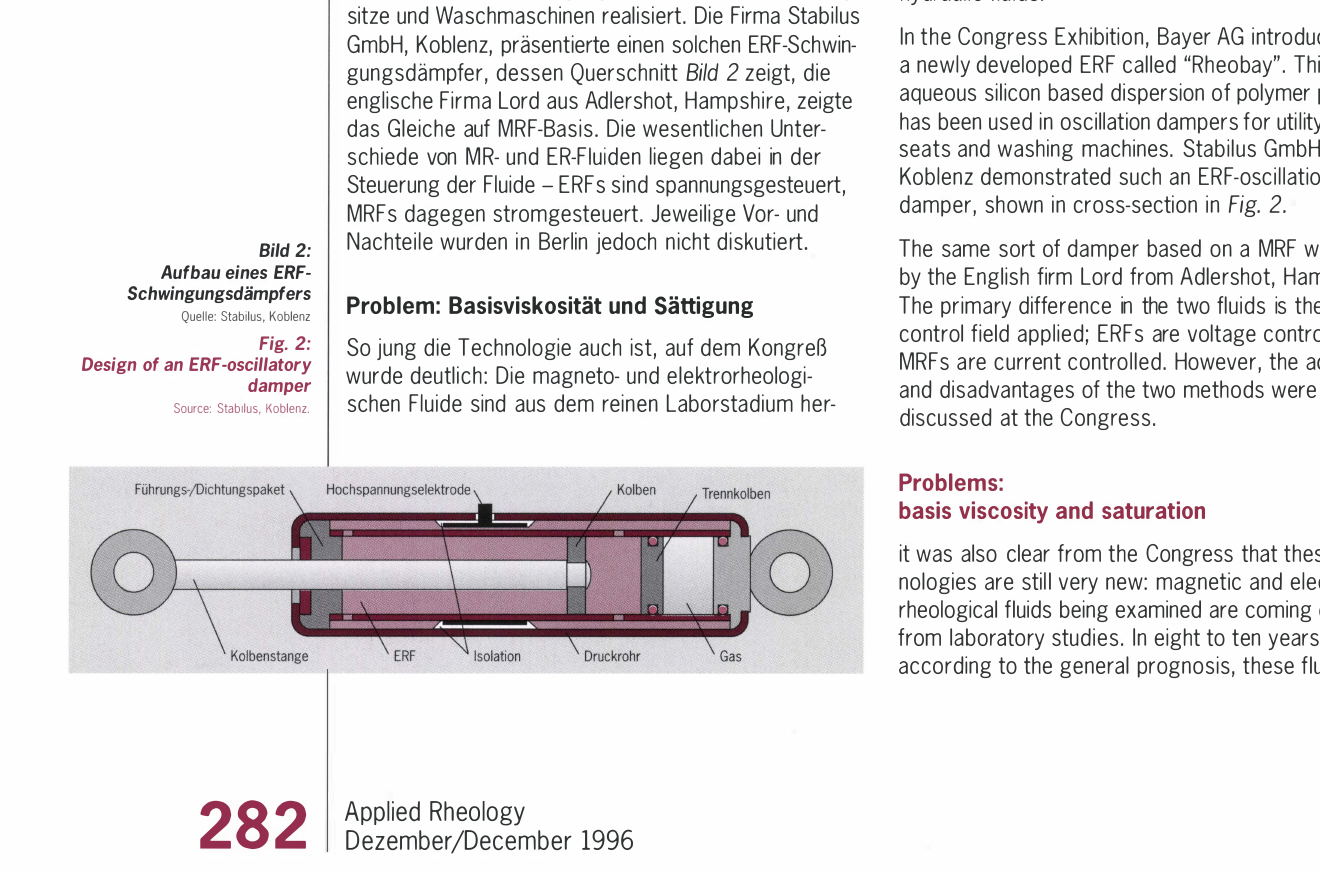
Fig. 2: Design of an ERF-oscillatory damper Source: Stab1lus, Koblenz.